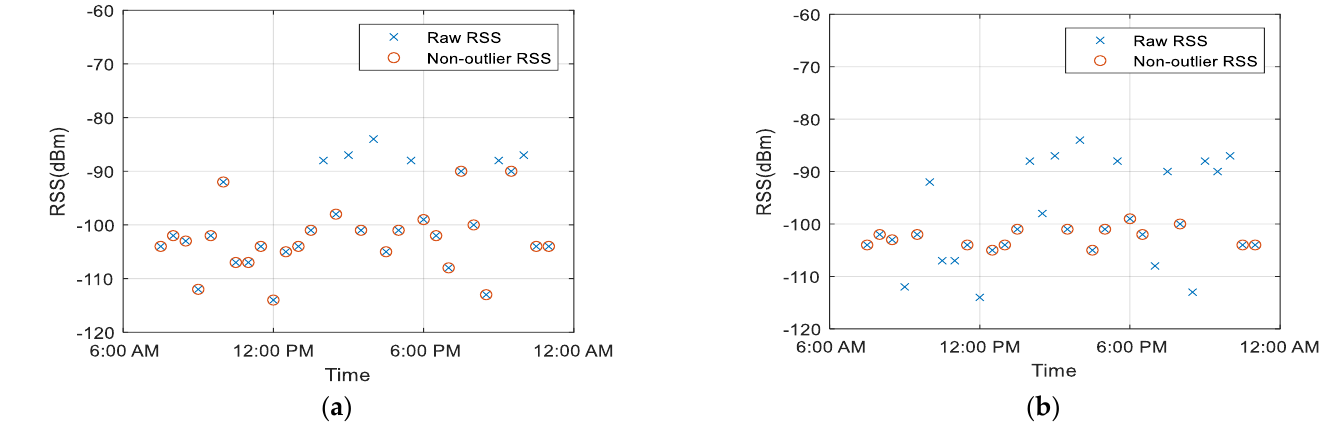
Figure 4. RSS outlier detection comparison for RSS Dataset 2. ( a ) 𝑆 𝑛 scale estimator, and ( b ) MAD scale estimator.